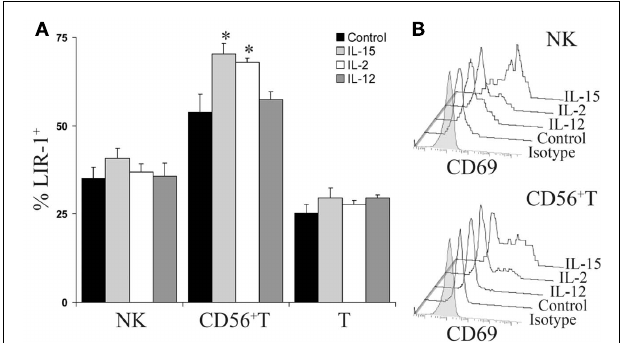
FIGURE 4 | IL-15 and IL-2 increase LIR-1 + CD56 + T cells in PBMC cultures. (A) Donor peripheral blood mononuclear cells were stimulated ex vivo with IL-15, IL-2, IL-12, or media alone for 24h and the three lymphocyte subsets were then examined for LIR-1 expression by flow cytometry. Error bars indicate the SEM ( n = 5). Representative results for D230 are shown (* P < 0.05). (B) CD69 expression profiles of NK cells and CD56 + T cells following 24h cytokine stimulation. Representative results from an assay with D230 are shown.T cell histograms are excluded as CD69 expression was not induced over 24h culture under all conditions.